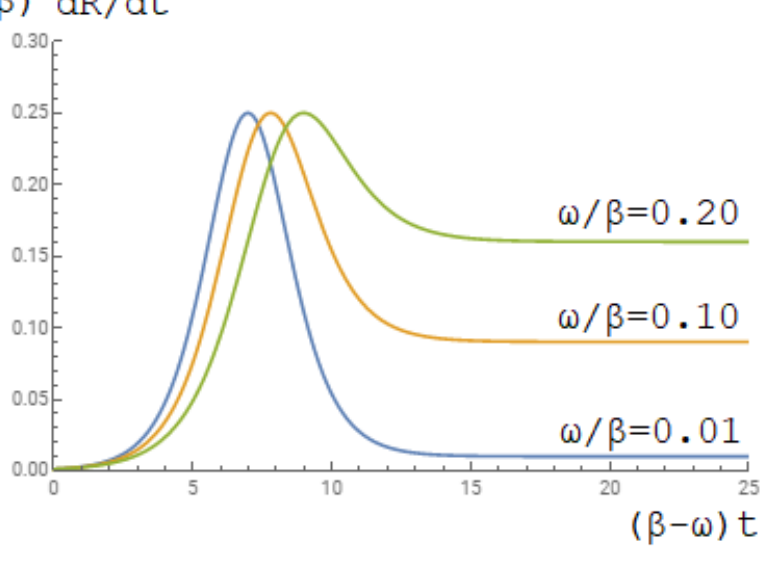
Figure 3. The course of daily incidence 𝒅𝑹/𝒅𝒕 in the random decay approach, depending on the ratio